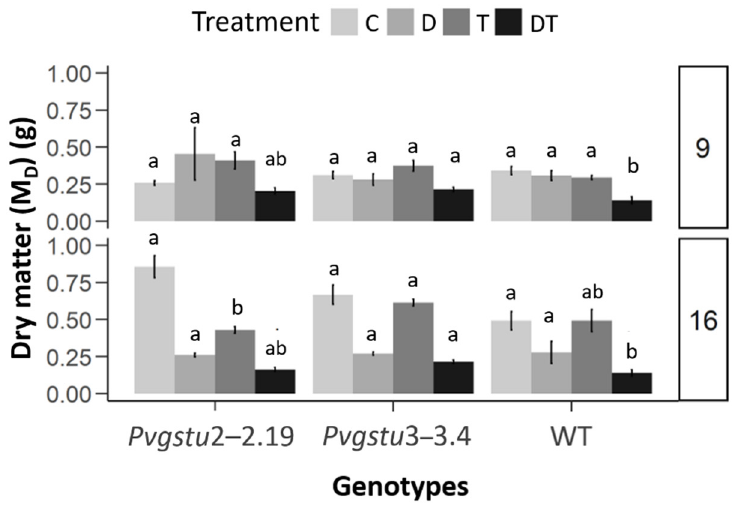
Figure 1. Effect of heat (T), drought (D) and combination of drought and heat (DT) stress on the growth of transgenic lines ( Pvgstu3–3.4 and Pvgstu2–2.19 ) and wild-type (WT) tobacco plants after 9 days compared to the stress-free, control (C) conditions. It is interesting that under single D or T stresses did not show any significant wilting as compared to the DT treatment.